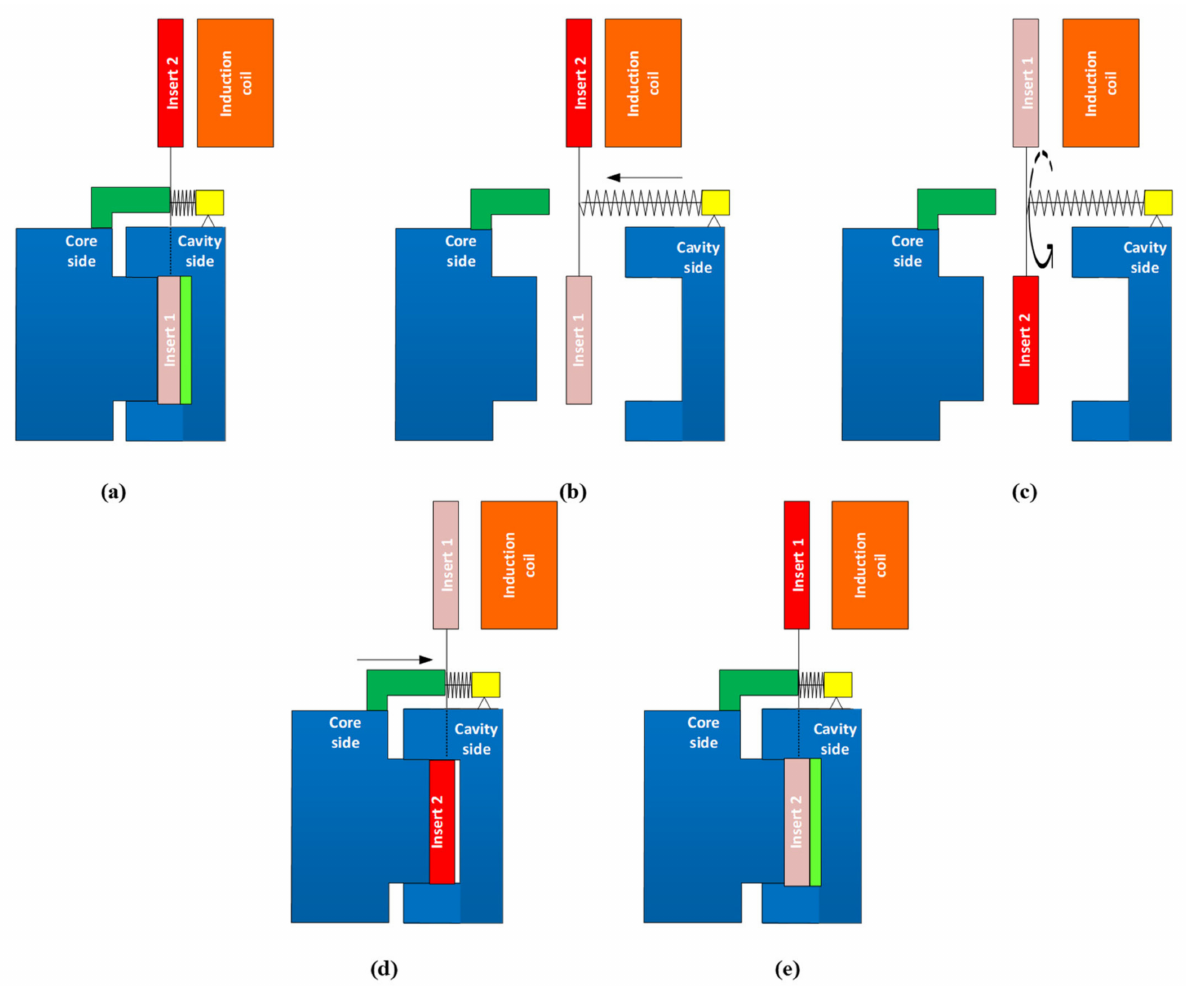
Figure 2. Mold steps in the heating stage of Ex-IH process: ( a ) at the end of molding process; ( b ) mold opening for insert changing; ( c ) the rotation device changes the location of hot and cool insert; ( d ) mold closing with the high-temperature insert inside the cavity; and ( e ) the molding starts as the traditional molding